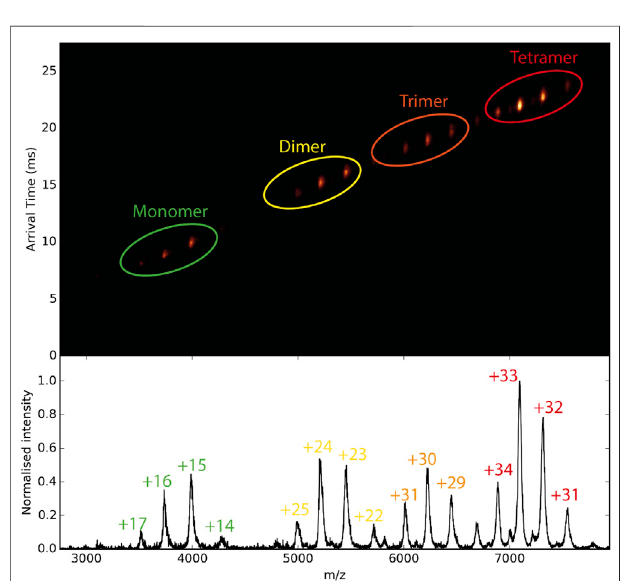
FIGURE 7 | Schematic diagram of ion mobility data. In the middle, the mobilogram is shown where the drift time and m/z are combined in 2D representation. With the increasing mass of the protein, the drift time of each species